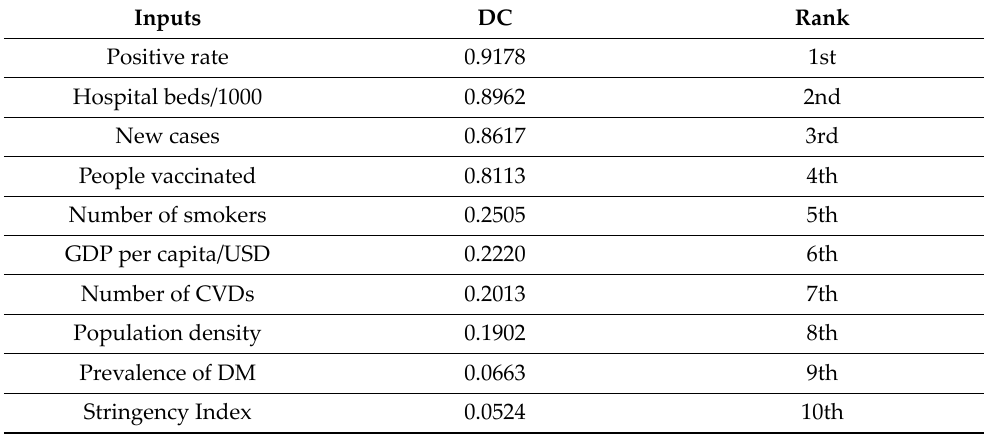
Table 3. Sensitivity analysis used to rank the inputs for the COVID‑19 model